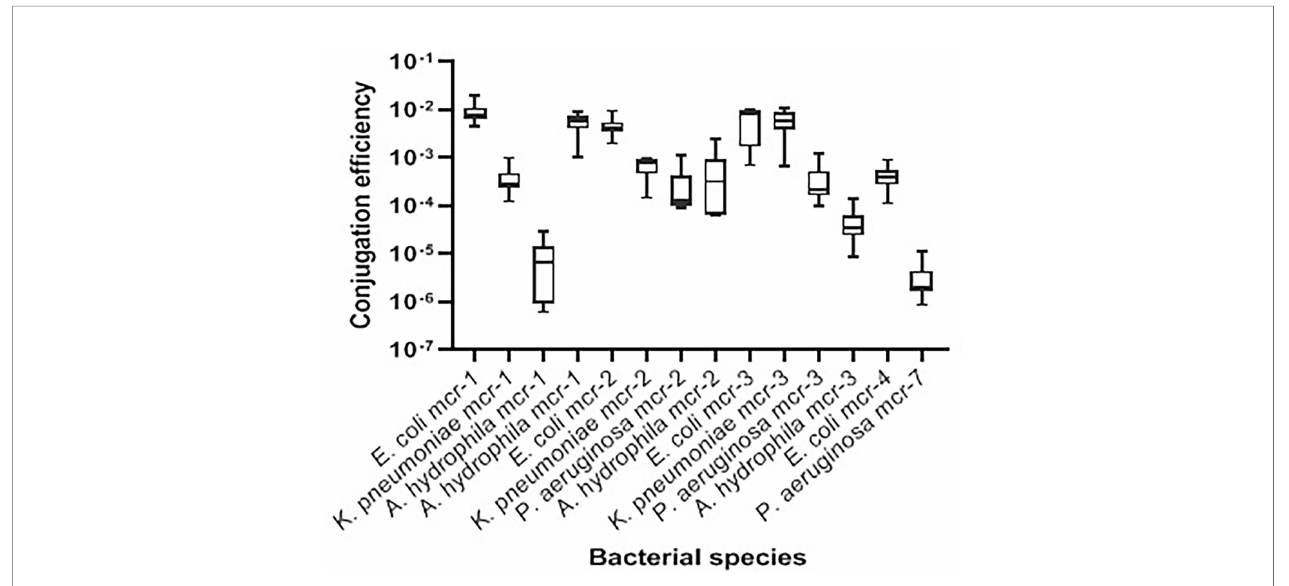
FIGURE 3 | Transconjugation frequencies of 14 mcr -harboring Gram-negative isolates from bovine milk. The data are presented as mean values ± standard deviations. Code numbers of isolates are shown in Table 2 .